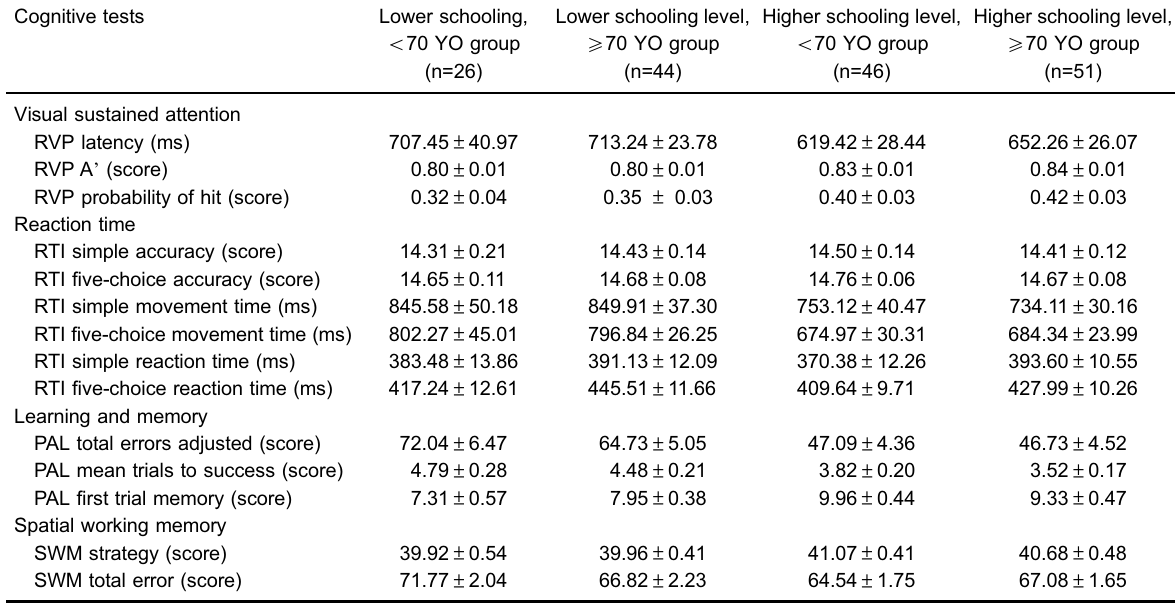
Table 2. Cognitive performance scores of the studied